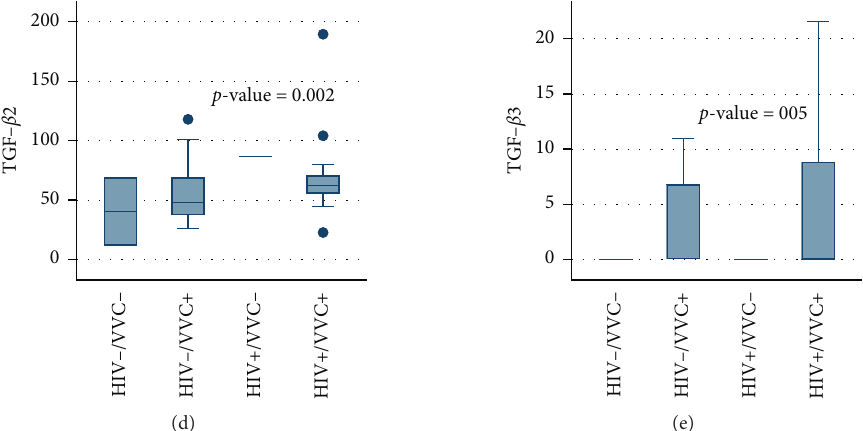
Figure 1: Multiple comparisons of the mean concentrations of (a) IL-1 β , (b) MIP-1 β , (c) TGF- β 1, (d) TGF- β 2, and (e) TGF- β 3 using Bonferroni post hoc tests.